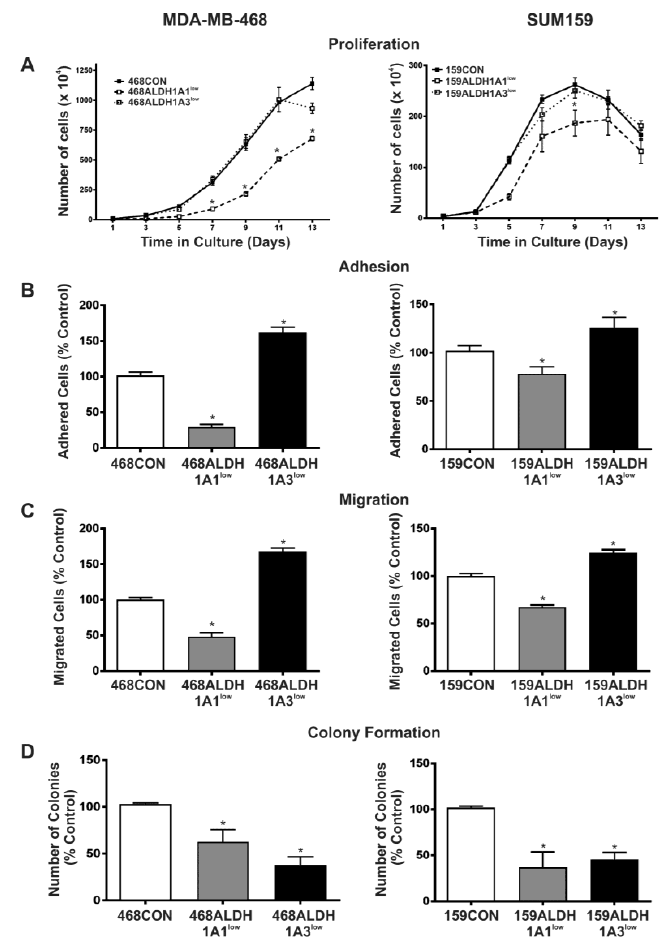
Figure 3. Decreased expression of ALDH1A1 reduces breast cancer cell proliferation, but adhesion and migration of human breast cancer cells is differentially influenced by ALDH1A1 versus ALDH1A3 in vitro. MDA-MB-468 (left panels) and SUM159 (right panels) human breast cancer cells were treated with control siRNA (siCON) or ALDH-specific siRNA (siALDH1A1 or siALDH1A3) for 96 h to generate the following cell lines: 468CON, 468ALDH1A1 low , 468ALDH1A3 low , 159CON, 159ALDH1A1 low , 159ALDH1A3 low . ( A ) Proliferation; ( B ) adhesion assays; ( C ) migration; and ( D ) colony formation. In all cases, data represents the mean ± SEM normalized to respective scrambled control. * = significantly different than respective scrambled control ( p < 0.05).